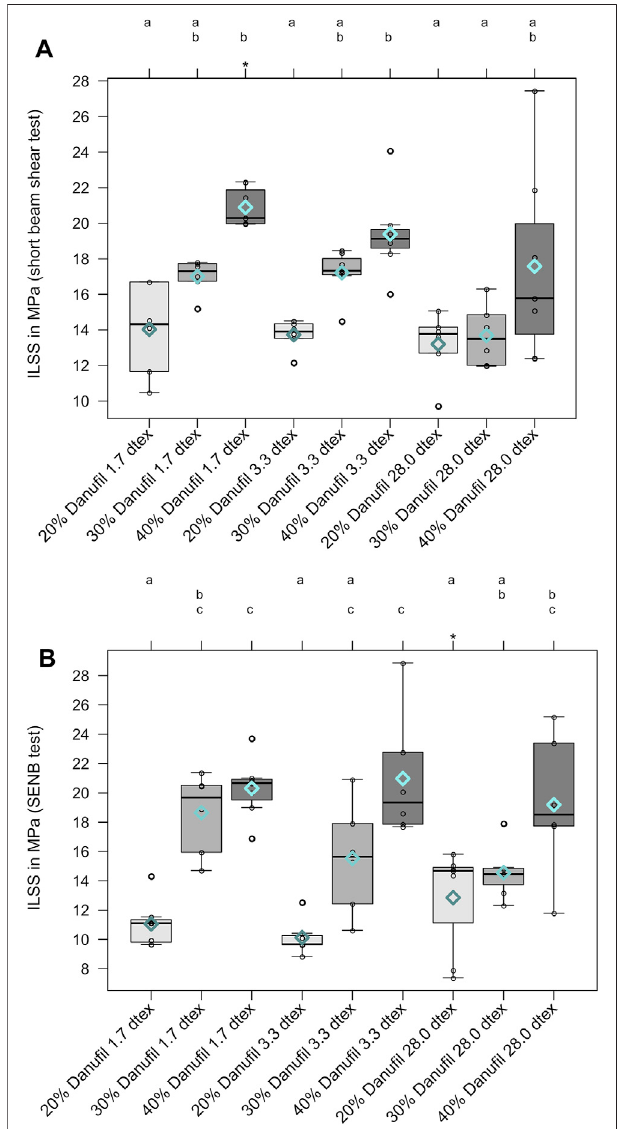
FIGURE 10 | Interlaminar shear strength (ILSS) determined by a short beam shear test (A) and ILSS determined by a SENB test (B) . Results are shown as Box-Whisker-Plots with mean values as rhombuses. Different letters indicate signi fi cant differences. A * marks results which do not follow a normal